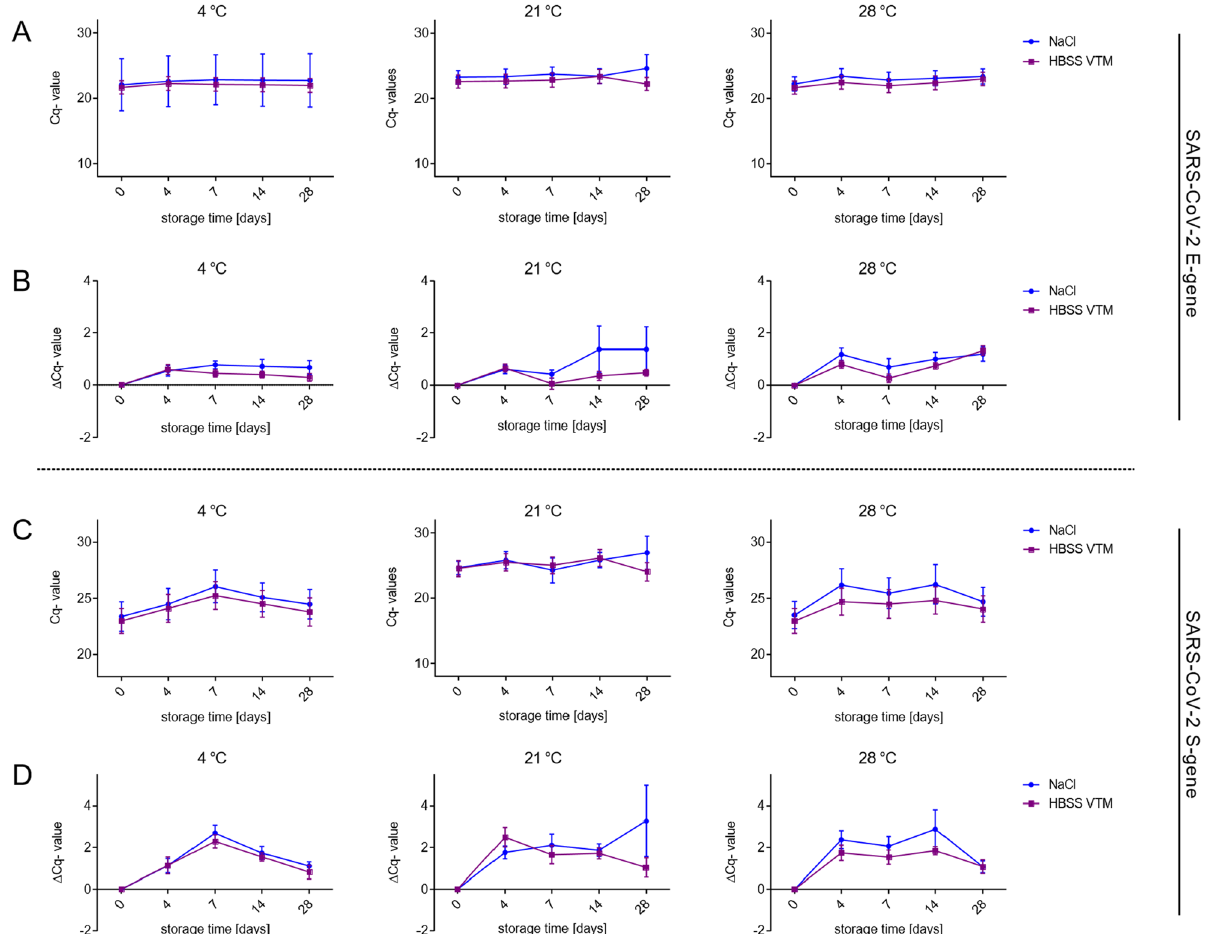
Figure 1. HBSS VTM and saline are both suitable transport media for SARS-CoV-2 specimens at storage temperatures up to 28 °C. RT-PCR measurements of clinical specimens positive for SARS-CoV-2 stored in NaCl (blue point) or HBSS VTM medium (purple rectangle) over 4 weeks at 3 different temperatures (4 °C, 21 °C and 28 °C). ΔCq-values ± SEM for SARS-CoV-2 at 4 °C, 21 °C and 28 °C n = 12 for NaCl and HBSS VTM, respectively, are shown. * p -values < 0.05, repeated measurement